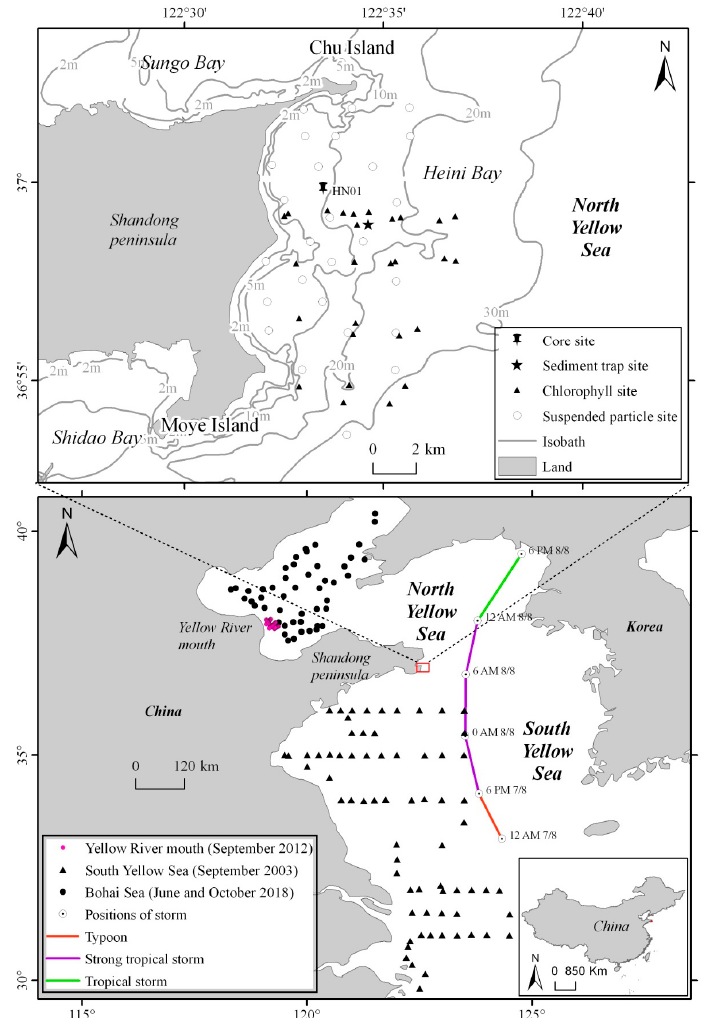
Figure 1. Map showing the locations at which suspended particle samples were collected in Bohai Sea, Yellow River mouth, South Yellow Sea, and Heini Bay, as well as the chlorophyll samples collected in Heini Bay. The core site collection location, sediment trap site, and strong storm track are noted.